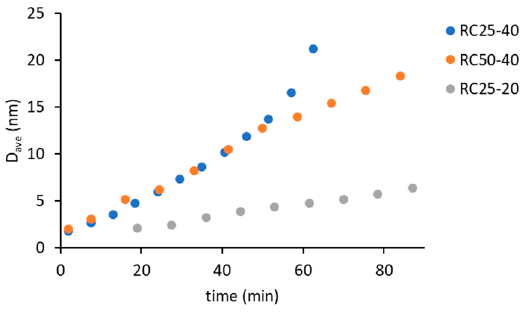
Figure 2. Dependence of average particle diameter in the studied RF mixtures.